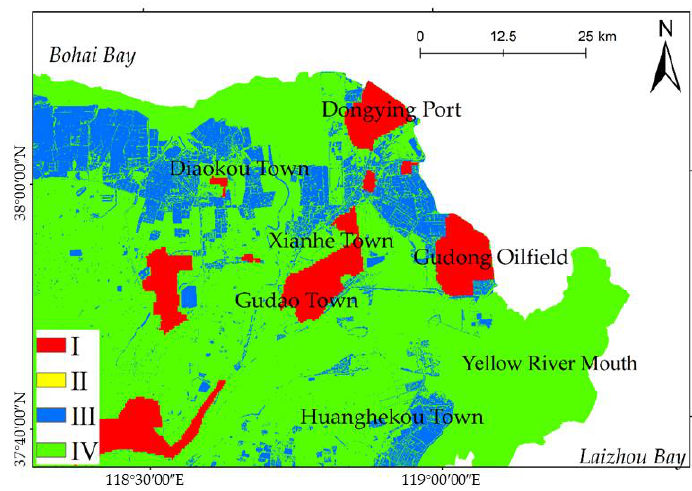
Figure 11. Vulnerability levels of storm surge in the YRD.